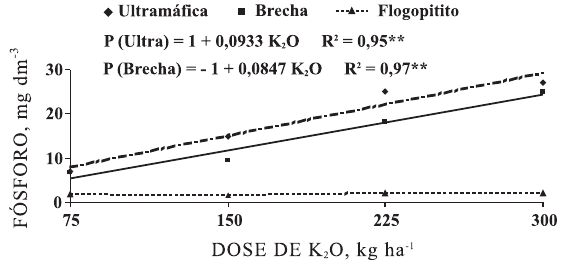
Figura 2. Fósforo disponível no solo após 45 dias de incubação com pó de rochas silicáticas portadoras de